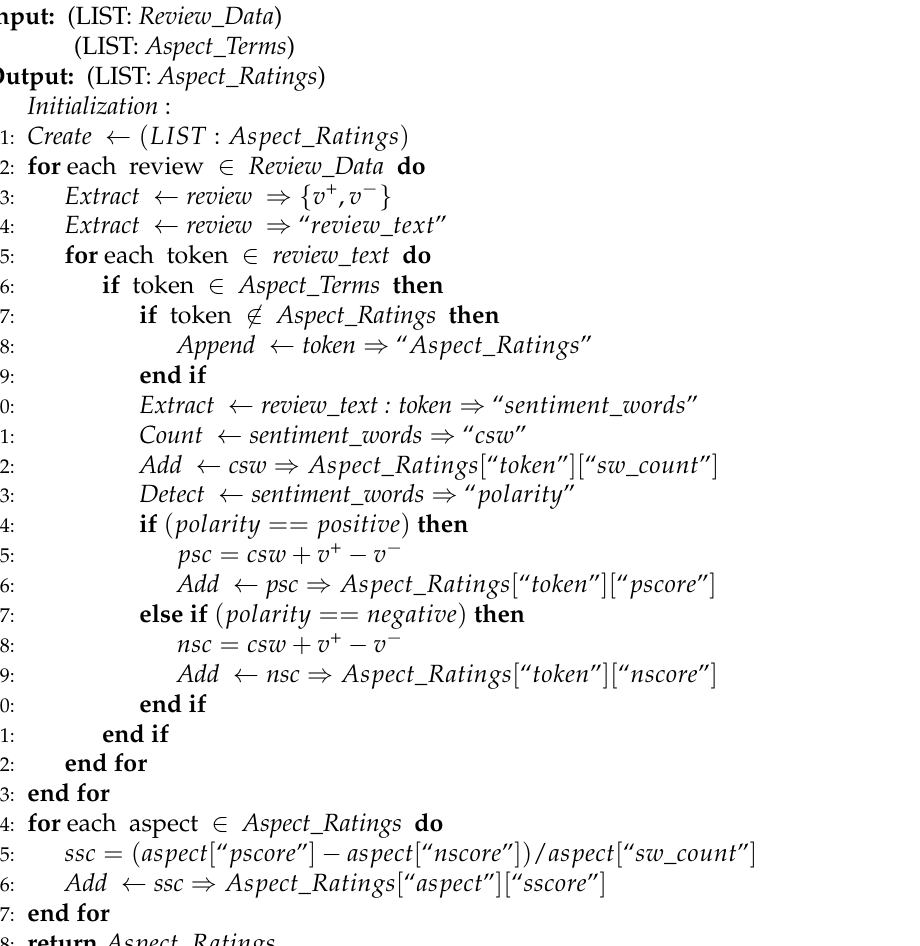
Algorithm 1 Computing the sentiment